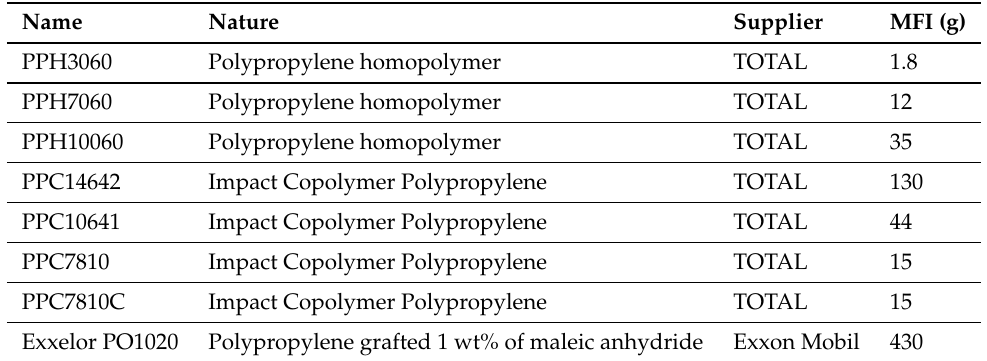
Table 1. Nature, supplier, and melt flow index –MFI– (216 kg/230 ◦ C/10 min) of PP polymers.